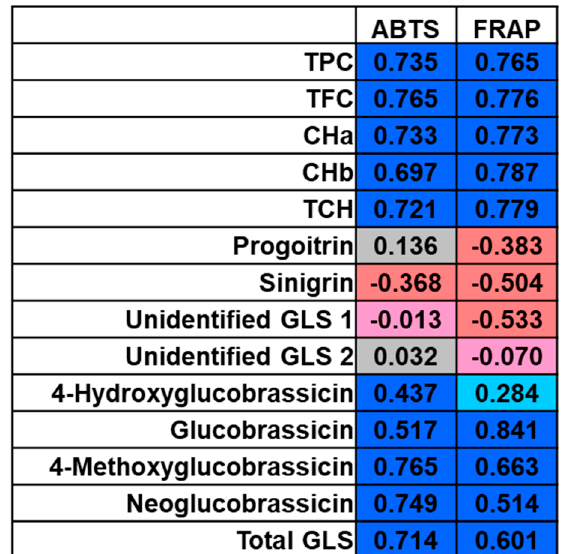
Figure 2. Heatmap representation of the correlations between antioxidant capacity and the phyto- chemicals analyzed in the aerial parts of cauliflower. ABTS—2,2 ′ -azino-bis (3-ethylbenzothiazoline- 6-sulfonic acid) (ABTS)—radical cation-based assay; FRAP—ferric reducing antioxidant potential